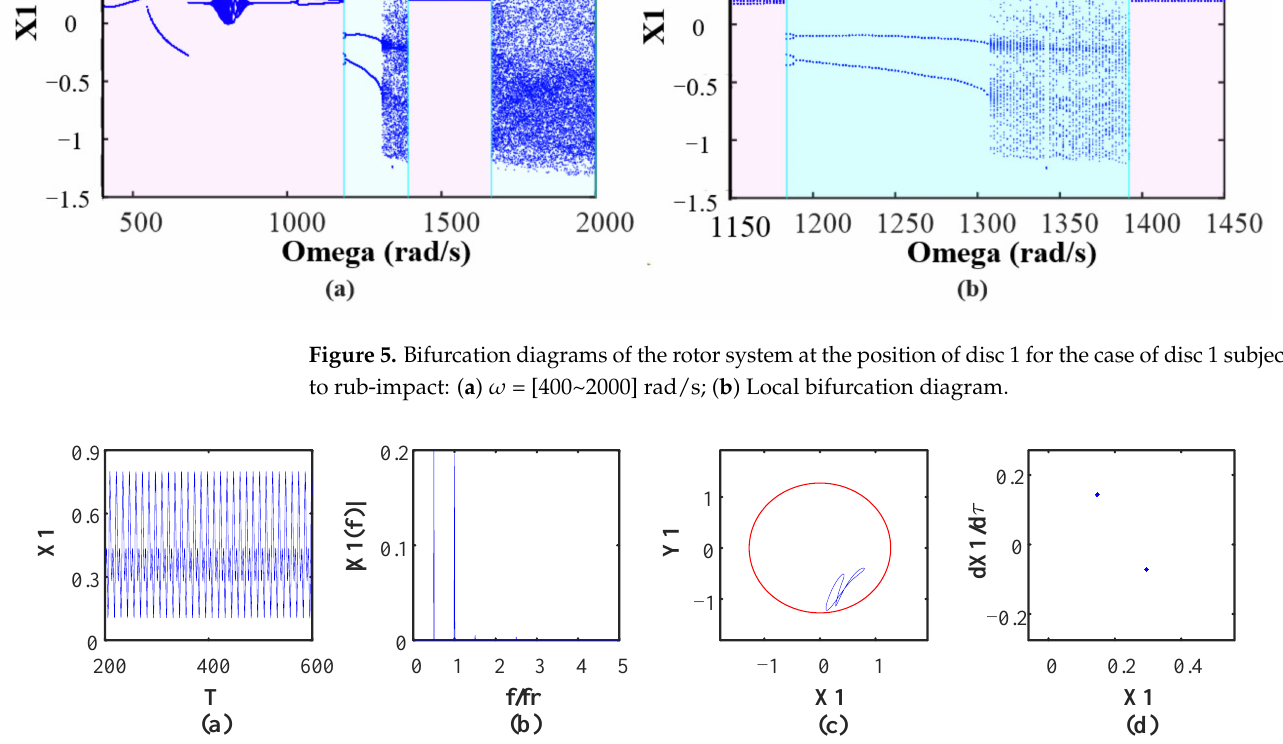
Figure 8. Numerical integration results at ω = 754 rad/s: ( a ) Time domain waveform; ( b ) Frequency spectrum; ( c ) Shaft orbit; ( d ) Poincaré map.